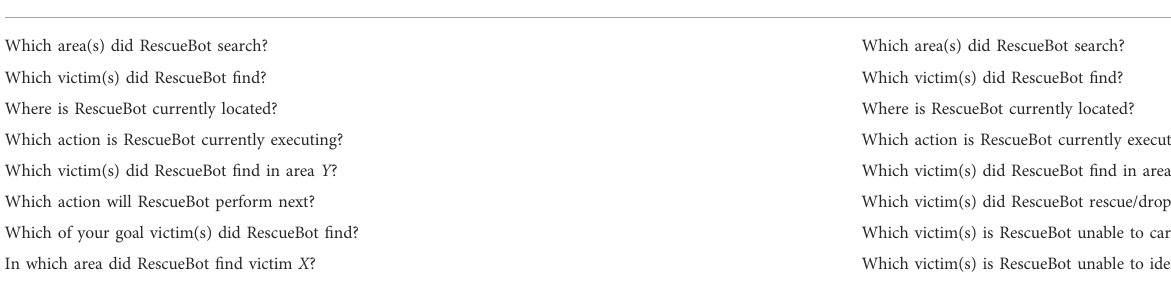
TABLE 2 The SAGAT queries used during the experiment, for each interdependence condition. Low Interdependence High